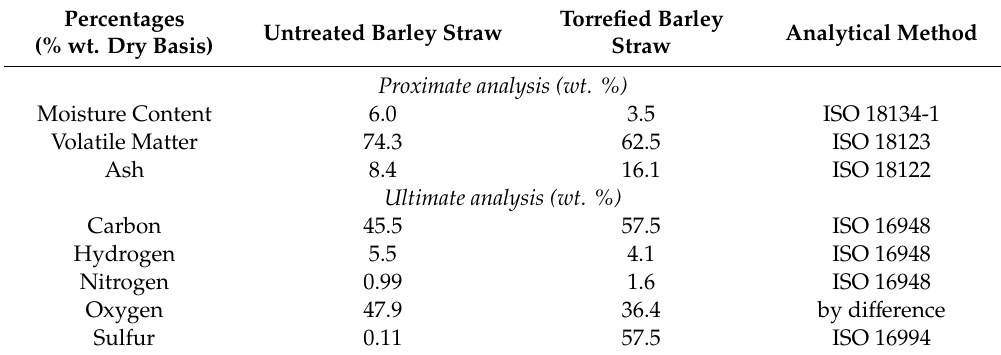
Table 2. Composition of untreated and torrefied barley